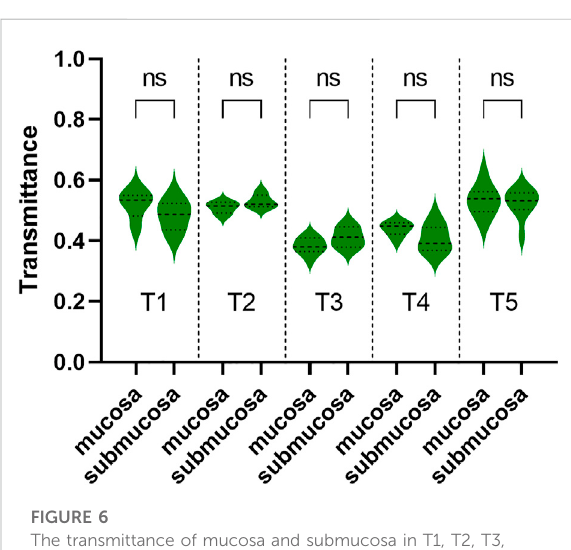
FIGURE 6 The transmittance of mucosa and submucosa in T1, T2, T3, T4, and T5. The transmittance of these two layers was similar in each of the three samples. ns: not signi fi